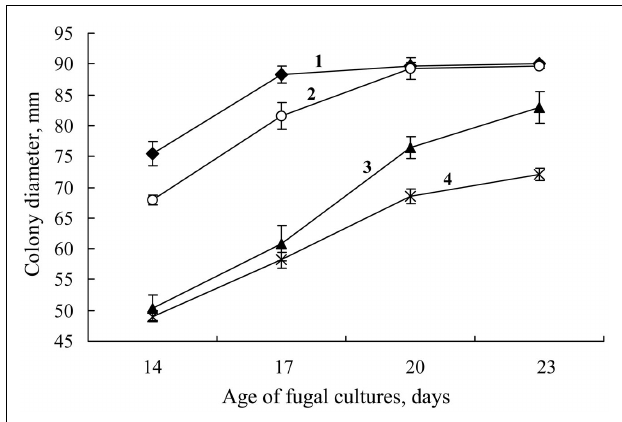
FIGURE 8 | Change in colony diameter of S. nodorum by number of days cultured on PDA or PDA supplemented with Dividend, alone, or Dividend combined with the filtrate of cultural liquid (FCL) of a biocontrol Fusarium sambucinum isolate FS-94. ( 1) Control colonies grown without the fungicide or FCL. ( 2) FCL, final concentration 2% by volume; ( 3) Dividend, 0.01ppm alone; ( 4) Dividend, 0.01ppm + FCL, 2 volume percent.